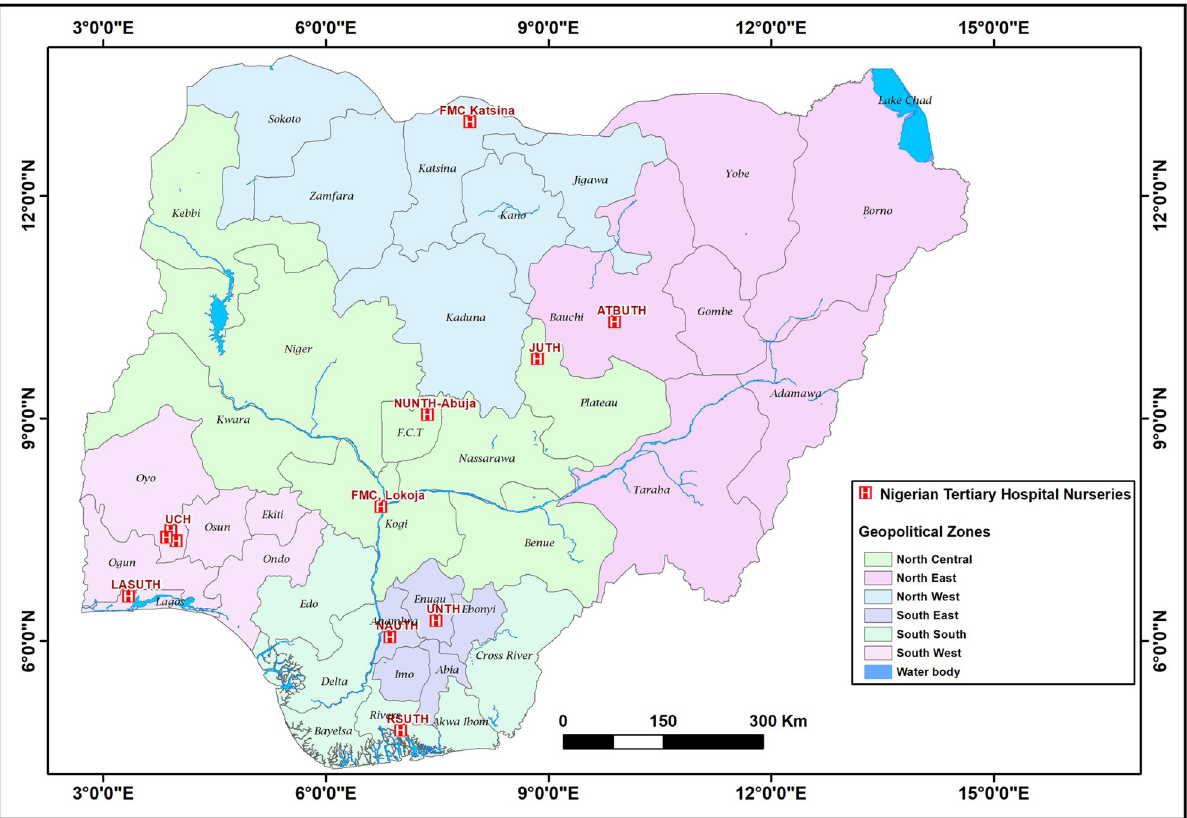
Fig 1. Map of Nigeria showing selected Nigerian tertiary hospital nurseries in the six geopolitical zones [UCH-University College Hospital, UITH- FMC-Katsina: Federal Medical Centre, Kastina, JUTH- Jos University Teaching Hospital, RSUTH-Rivers State University